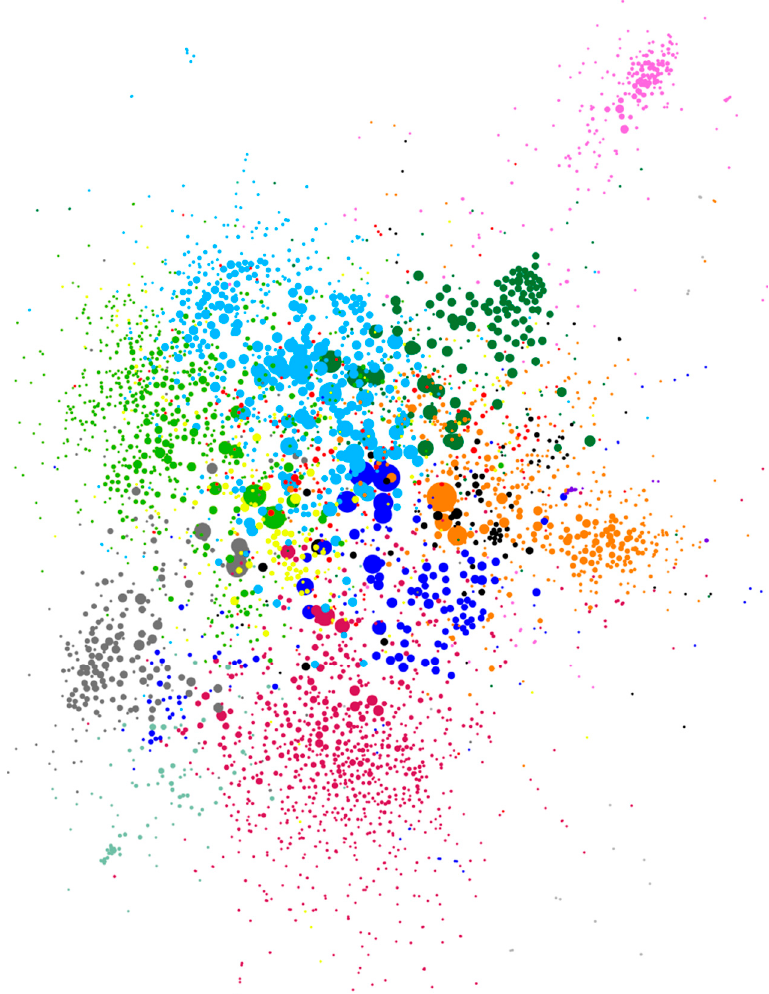
Figure A1. The base paper network and its 12 main clusters in its original version (4134 articles with degrees between 1 and 506). Table A1. Topics and data of each base paper network cluster.